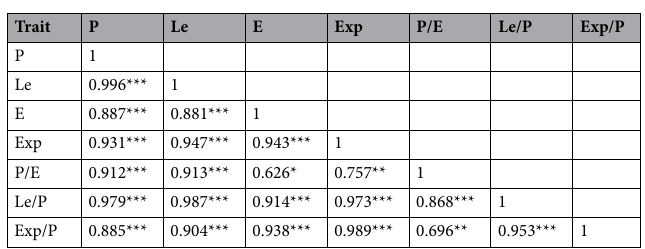
Table 4. Correlation coefficients between all pairs of traits. * P < 0.05; ** P < 0.01; *** P < 0.001; P – length of polar axis, E – equatorial diameter, Le – length of ectocolpus, Exp – thickness of exine along the polar